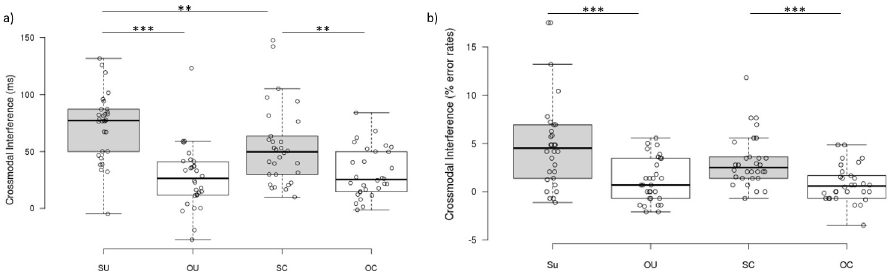
Fig 3. Crossmodal interference–three-way interaction. Crossmodal interference shown by Tool Arrangement (uncrossed [U], crossed [C]) and Visual Field (same [S], opposite [O]) for reaction times (A) and percentage error rates (B), on the Crossmodal Congruency Task (CCT), for all participants (n = 30). Crossmodal interference was calculated by subtracting congruent from incongruent reaction times and error rates. Medians are depicted by the centre lines. The box limits indicate the 25 th and 75 th percentile. The whiskers extend 1.5 times the interquartile range from the box limits. Circles depict individual data points. �� p < .01, ��� p <